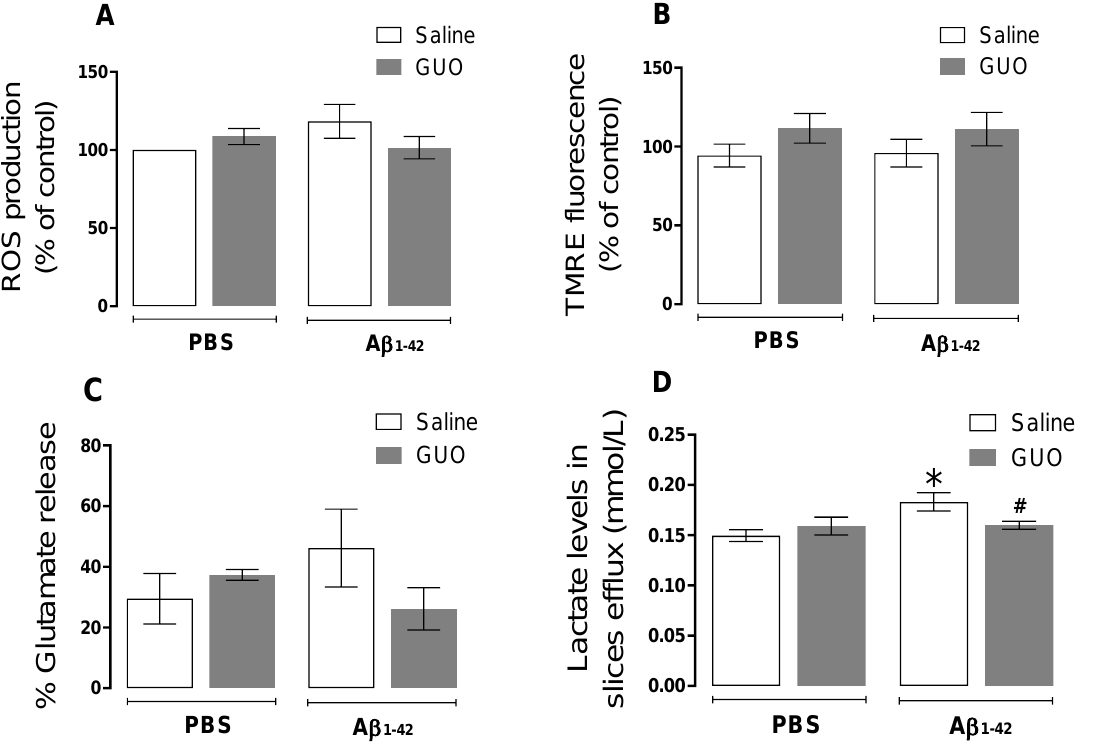
Figure 6. Biochemical evaluation of mice hippocampal slices following guanosine treatment and A β 1–42 i.c.v. infusion. Mice subjected to A β 1–42 infusion (400 pmol/site) received guanosine (GUO, 8 mg/kg, i.p.) for nine days. On the tenth day, animals were euthanized, and hippocampal slices were